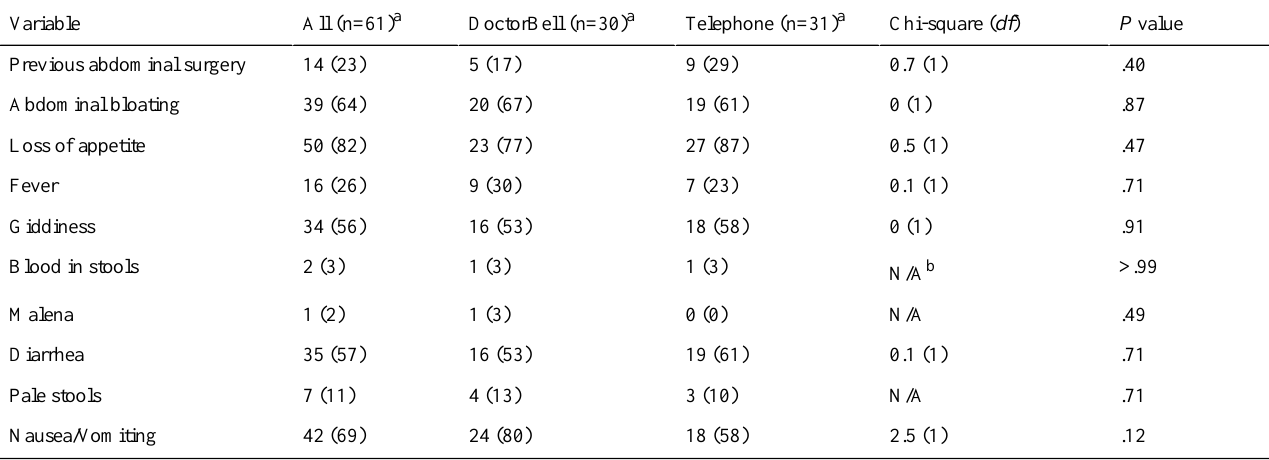
Table 2. Patient symptoms at presentation to hospital reported in a web-based survey via a link provided following patient recruitment.